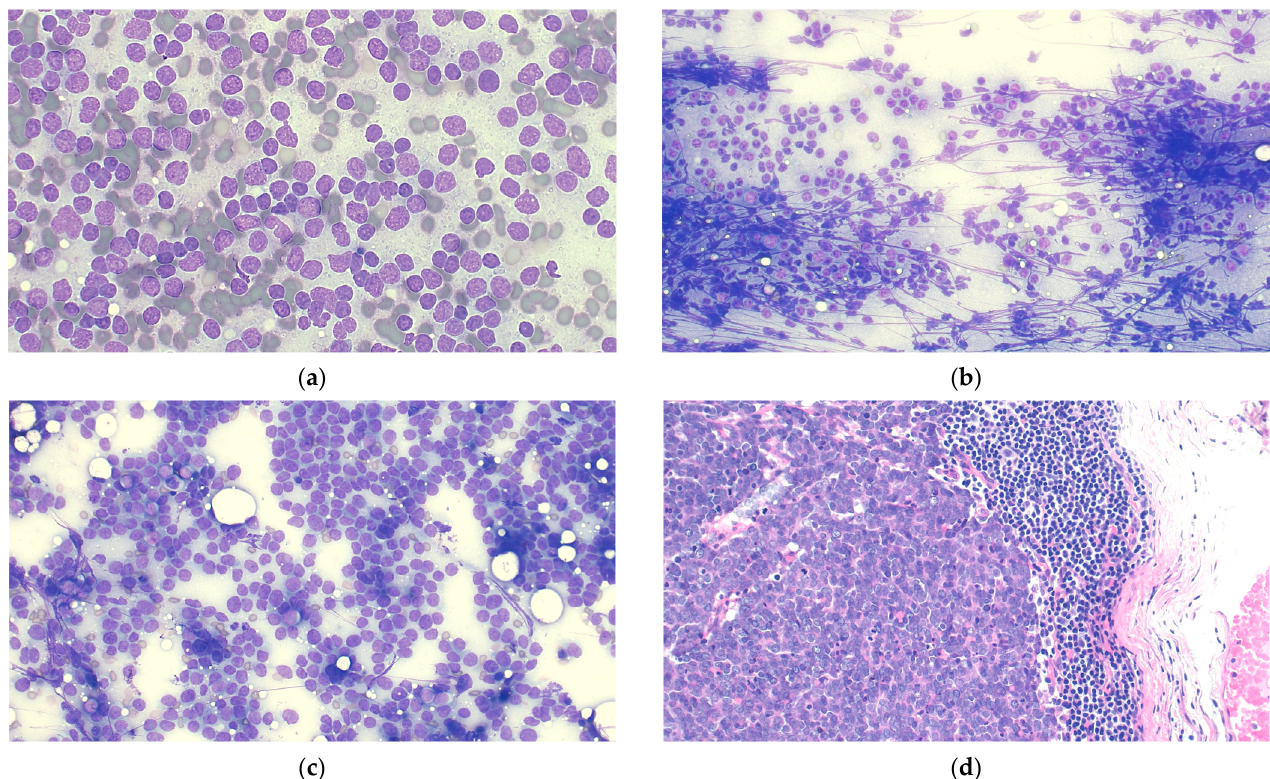
Figure 12. Potential false positive diagnoses. ( a ) Cytology of atypical cells from a follicular lymphoma. DQ ×400. ( b ) Smear of atypical cells in a node from a patient with chronic lymphocytic leukaemia (CLL). Note crush artefact. DQ ×200. ( c ) Smear from an axillary node with metastatic Merkel cell carcinoma DQ ×200, with corresponding node excision biopsy ( d ) H&E ×200.